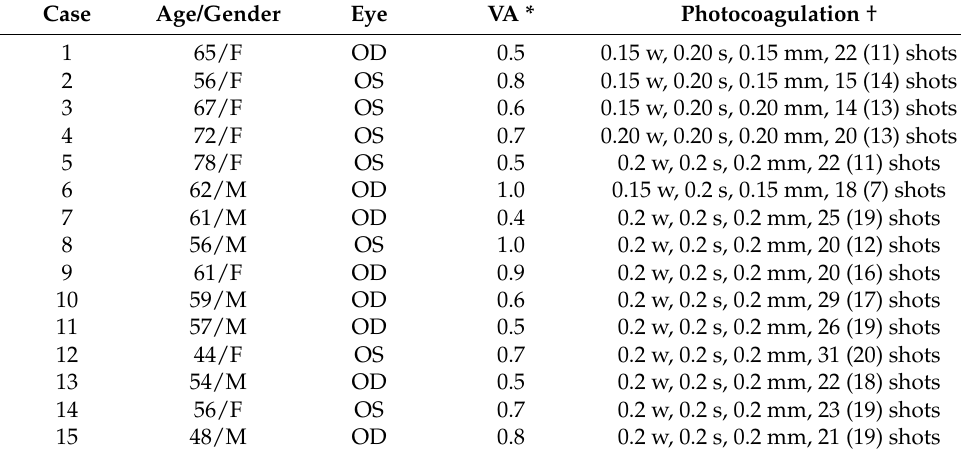
Table 1. Summary of